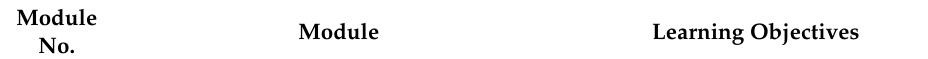
Table 1. Overview of the core program content in